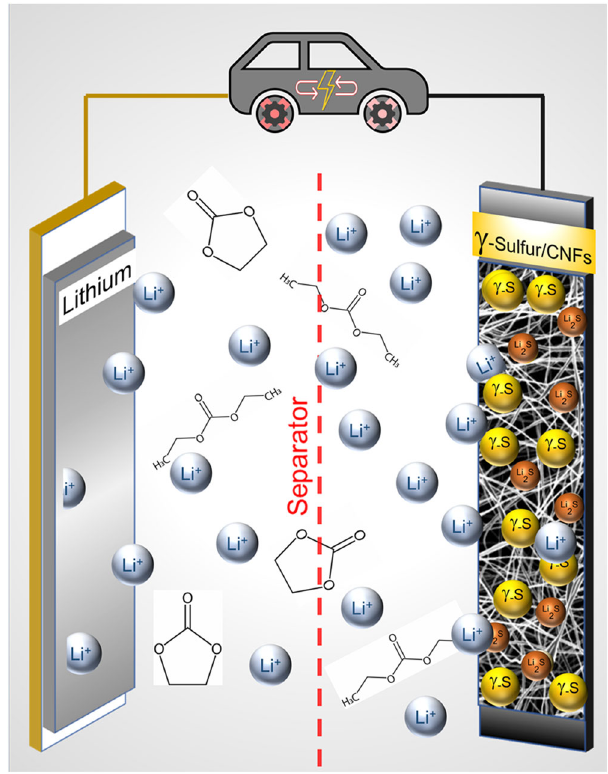
Fig. 1 Schematic of a lithium-sulfur battery discharge in the carbonate- based electrolyte. The gamma-monoclinic sulfur is deposited on the external surface of the carbon nano fi bers. The yellow balls signify surface deposited gamma-monoclinic sulfur, red balls signify lithium sul fi de, the product formed after the reduction of